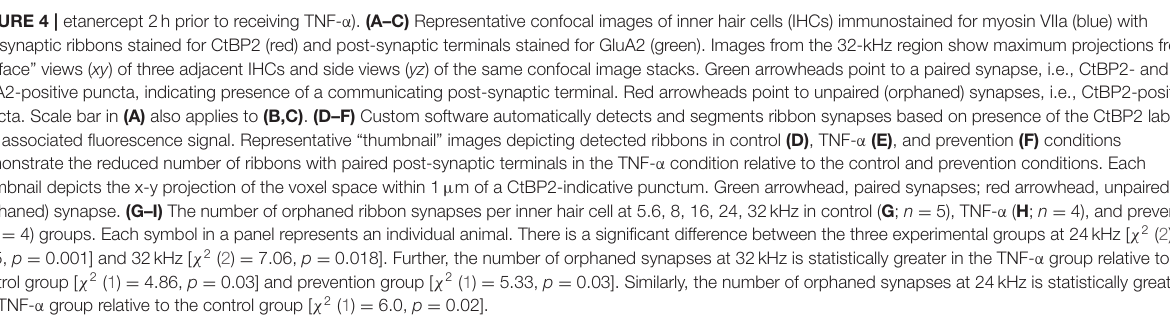
FIGURE 4 | etanercept 2h prior to receiving TNF- α ). (A–C) Representative confocal images of inner hair cells (IHCs) immunostained for myosin VIIa (blue) with pre-synaptic ribbons stained for CtBP2 (red) and post-synaptic terminals stained for GluA2 (green). Images from the 32-kHz region show maximum projections from “surface” views ( xy ) of three adjacent IHCs and side views ( yz ) of the same confocal image stacks. Green arrowheads point to a paired synapse, i.e., CtBP2- and GluA2-positive puncta, indicating presence of a communicating post-synaptic terminal. Red arrowheads point to unpaired (orphaned) synapses, i.e., CtBP2-positive puncta. Scale bar in (A) also applies to (B,C) . (D–F) Custom software automatically detects and segments ribbon synapses based on presence of the CtBP2 label and associated fluorescence signal. Representative “thumbnail” images depicting detected ribbons in control (D) , TNF- α (E) , and prevention (F) conditions demonstrate the reduced number of ribbons with paired post-synaptic terminals in the TNF- α condition relative to the control and prevention conditions. Each thumbnail depicts the x-y projection of the voxel space within 1 µ m of a CtBP2-indicative punctum. Green arrowhead, paired synapses; red arrowhead, unpaired (orphaned) synapse. (G–I) The number of orphaned ribbon synapses per inner hair cell at 5.6, 8, 16, 24, 32kHz in control ( G ; n = 5), TNF- α ( H ; n = 4), and prevention ( I ; n = 4) groups. Each symbol in a panel represents an individual animal. There is a significant difference between the three experimental groups at 24kHz [ χ 2 (2) = 9.05, p = 0.001] and 32kHz [ χ 2 (2) = 7.06, p = 0.018]. Further, the number of orphaned synapses at 32kHz is statistically greater in the TNF- α group relative to the control group [ χ 2 (1) = 4.86, p = 0.03] and prevention group [ χ 2 (1) = 5.33, p = 0.03]. Similarly, the number of orphaned synapses at 24kHz is statistically greater in the TNF- α group relative to the control group [ χ 2 (1) = 6.0, p =